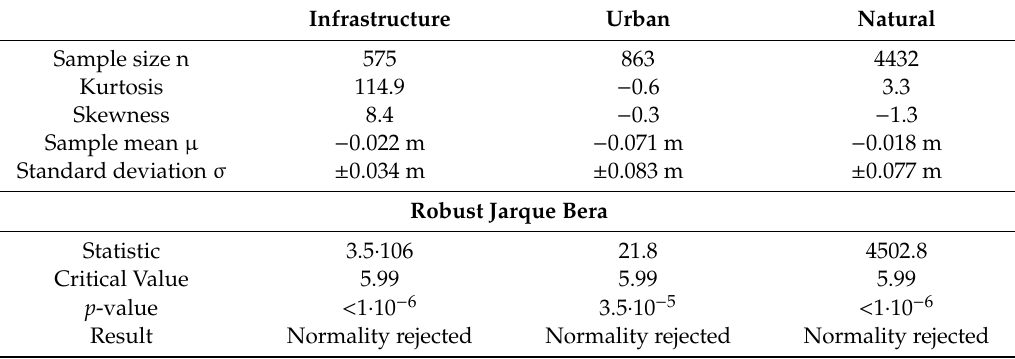
Table 5. Robust assessment for each study case.